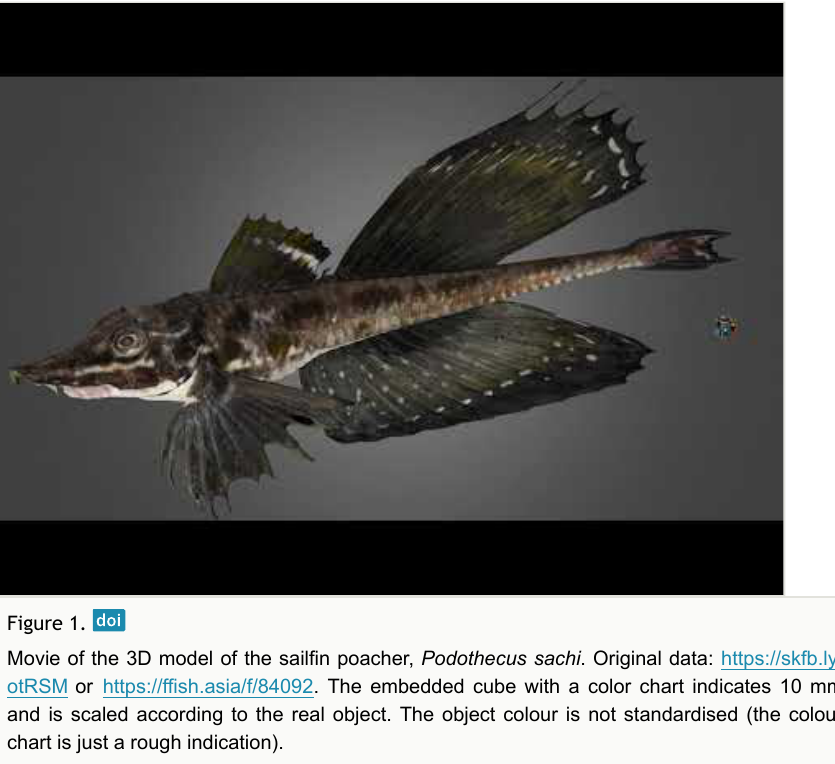
Figure 1. Movie of the 3D model of the sailfin poacher, Podothecus sachi . Original data: https://skfb.ly/ otRSM or https://ffish.asia/f/84092. The embedded cube with a color chart indicates 10 mm and is scaled according to the real object. The object colour is not standardised (the colour chart is just a rough